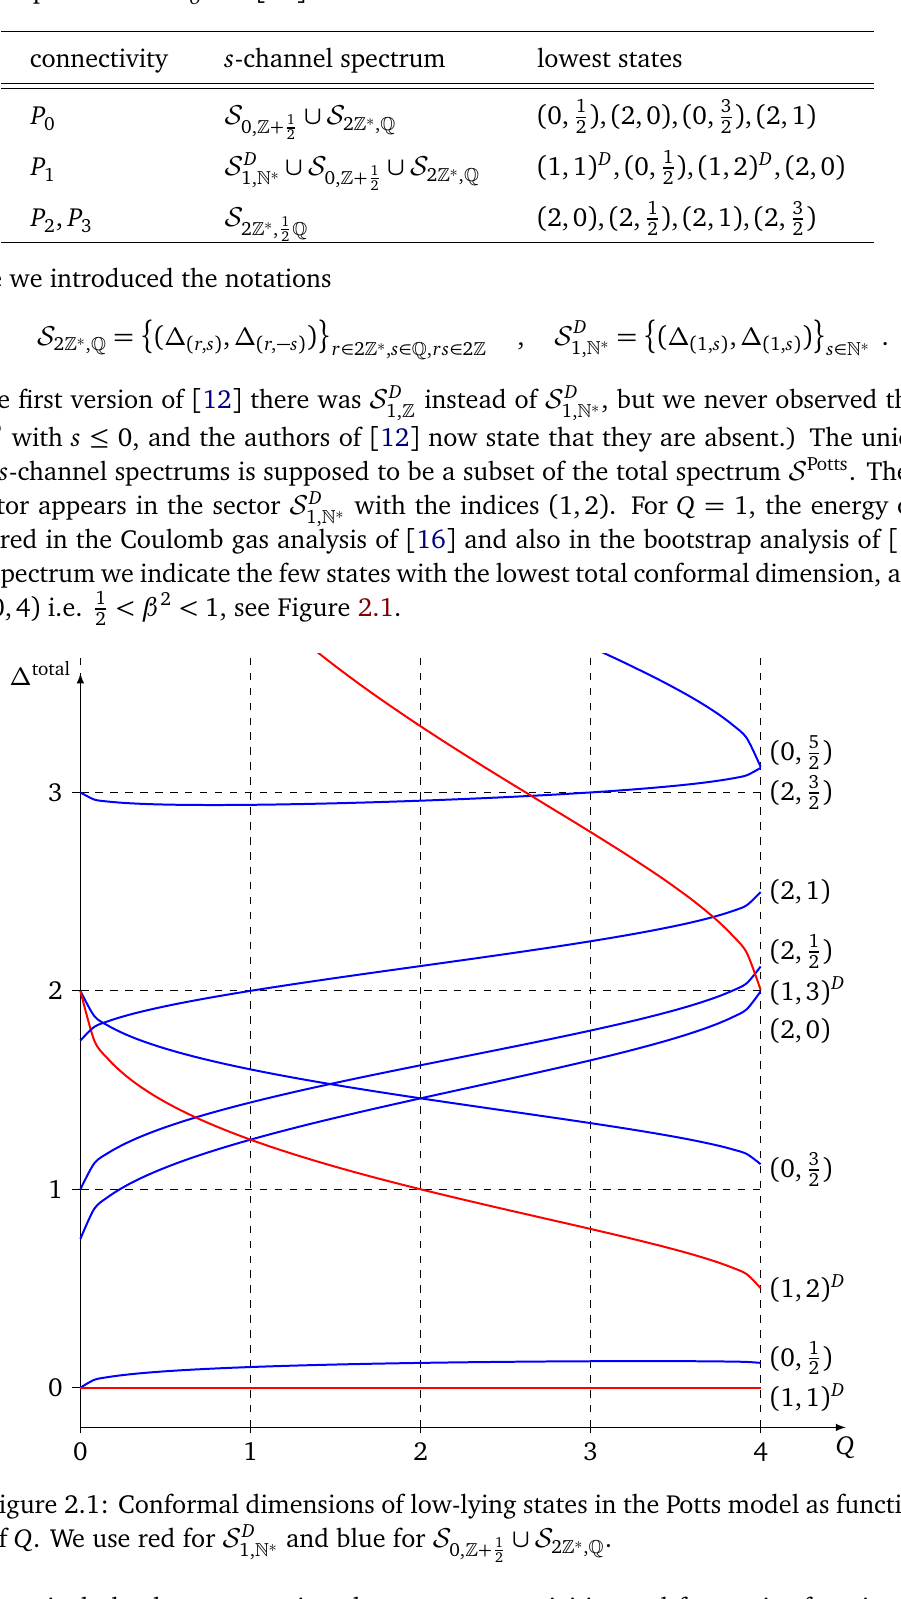
[ S and blue for S 2 Z (cid:3) , Q 0, Z + 1 1, N (cid:3) 2